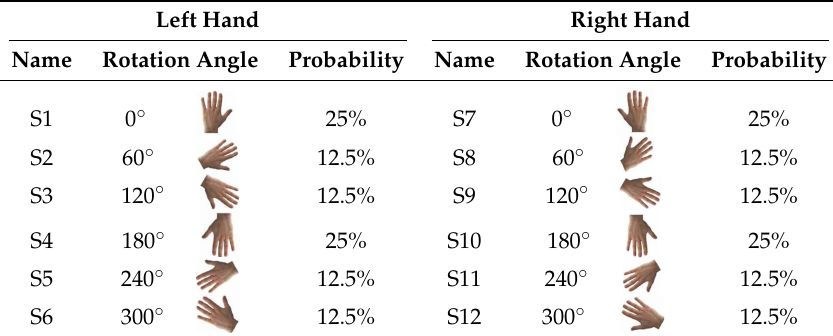
Table 1. Stimulus